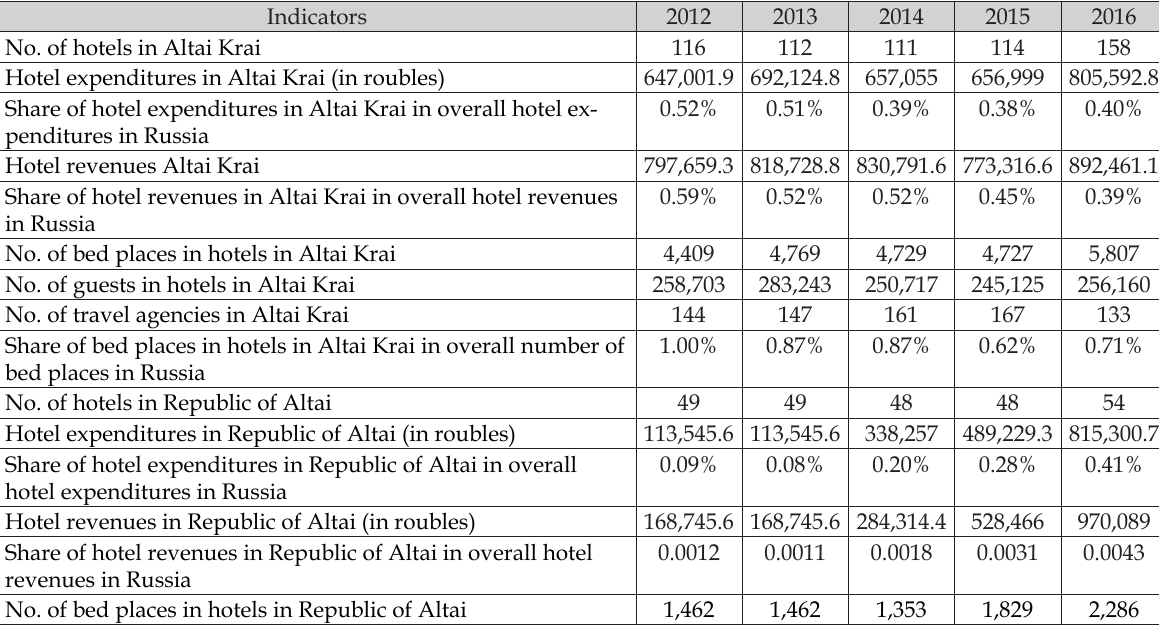
Table 2. The analysis of selected tourism indicators in the Altai Mountains.